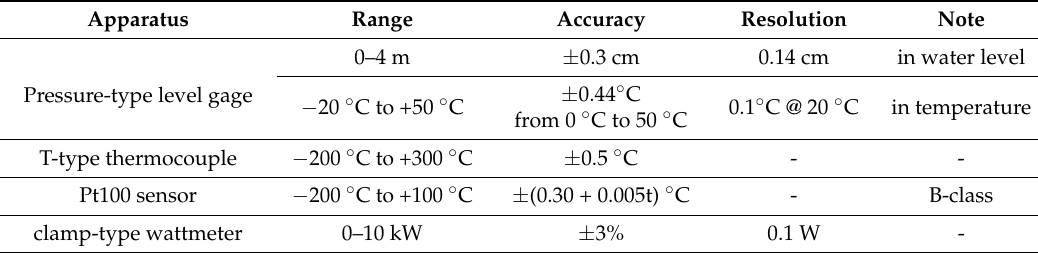
Table 3. Performance of the measurement apparatuses.